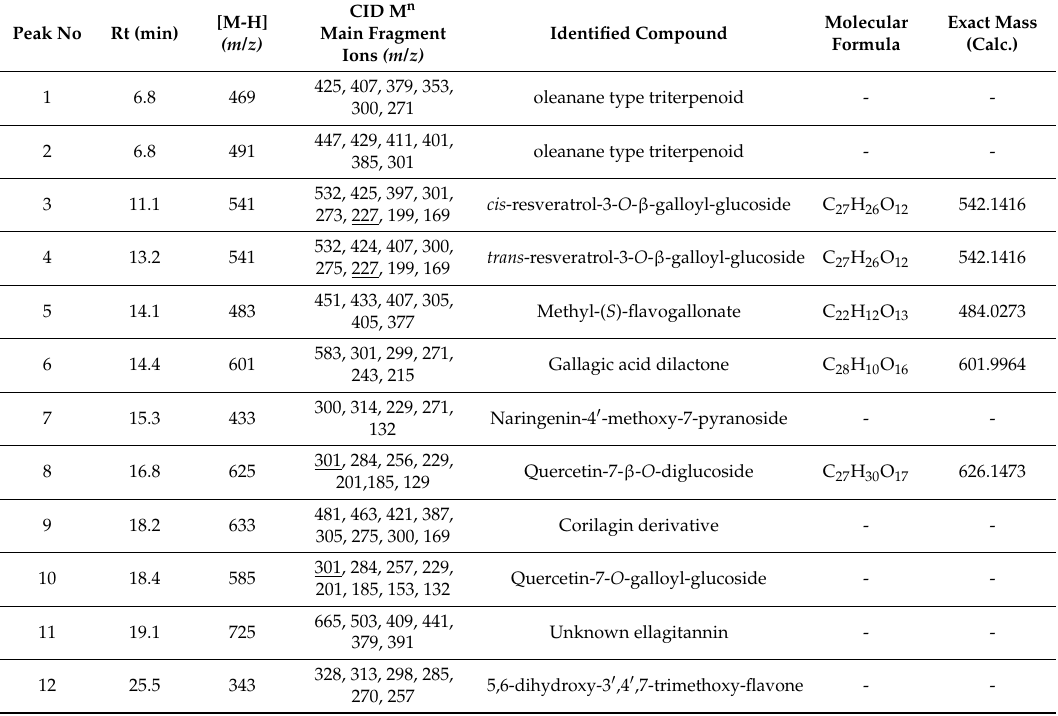
(Table 2). The MS 2 , MS 3 and MS 4 ion chromatograms are presented in the supplemental part of this paper (Supplement 1). Table 2. HPLC-DAD and MS/MS data of phenolic compounds and triterpenoids in an ethyl acetate extract of the stem wood of T. brownii